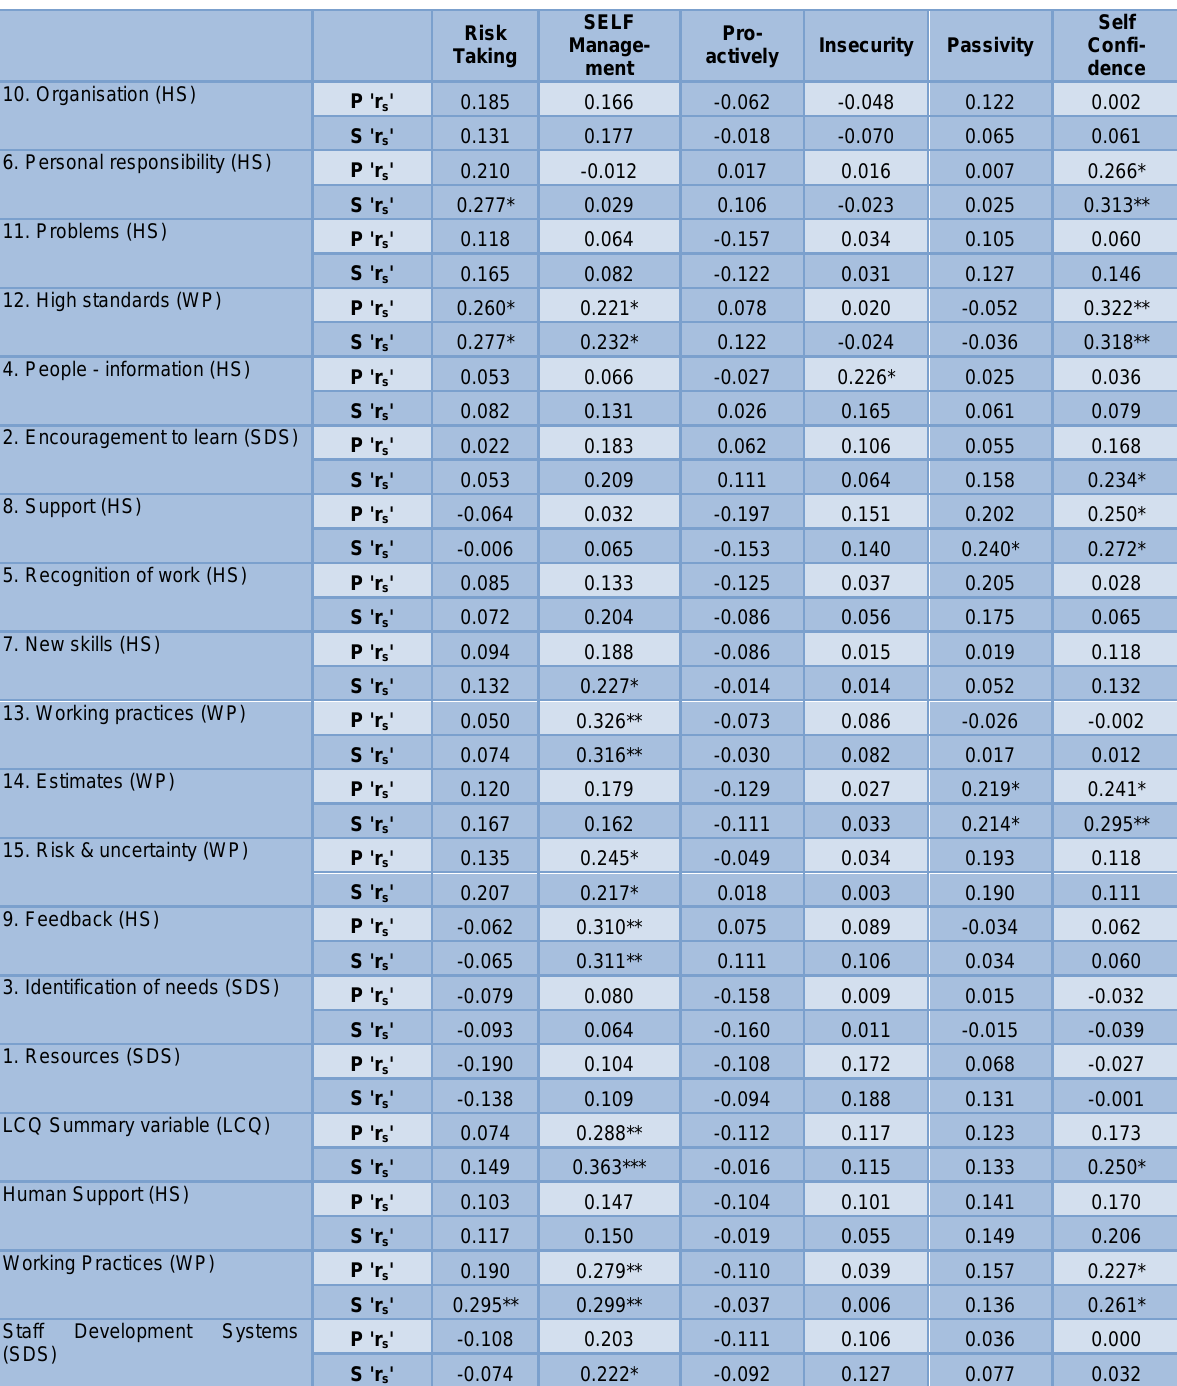
Table 8 Correlations between Learning Climate Questions and Approaches to Learning at work Questionnaire factor scores (n =